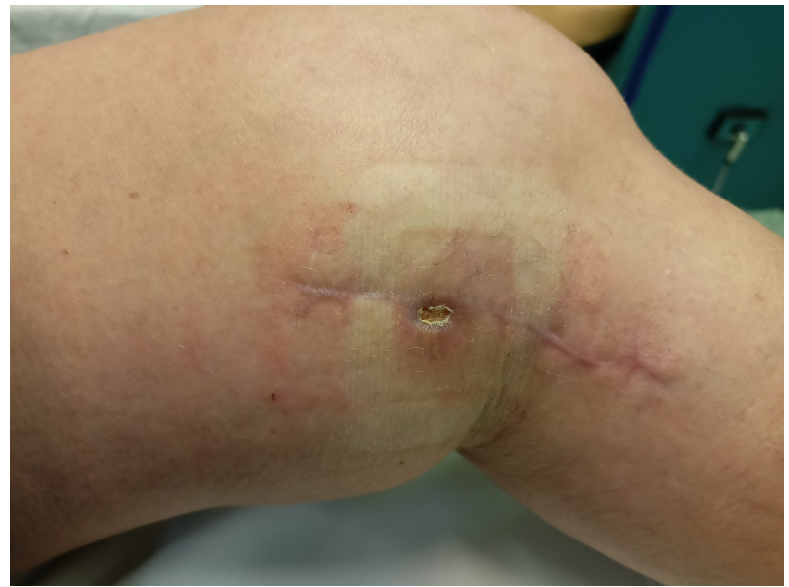
Figure 3. The local state of the wound after 15 topical ozone therapy procedures. The final treatment result is presented in Figure 4.